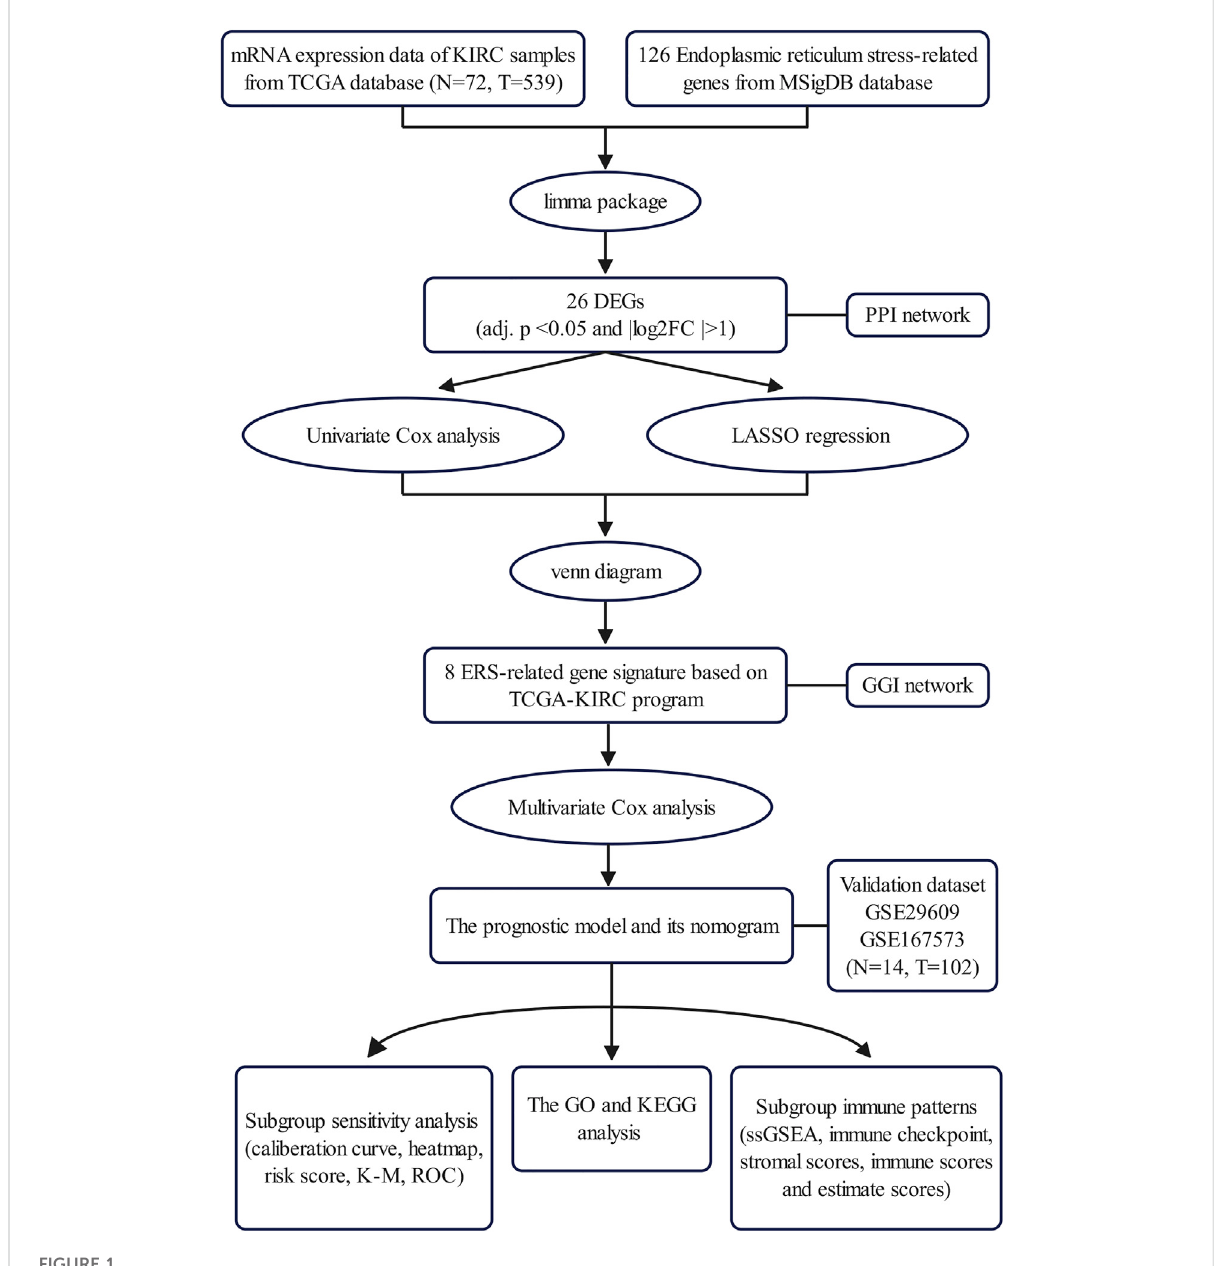
FIGURE 1 Outline of the analysis